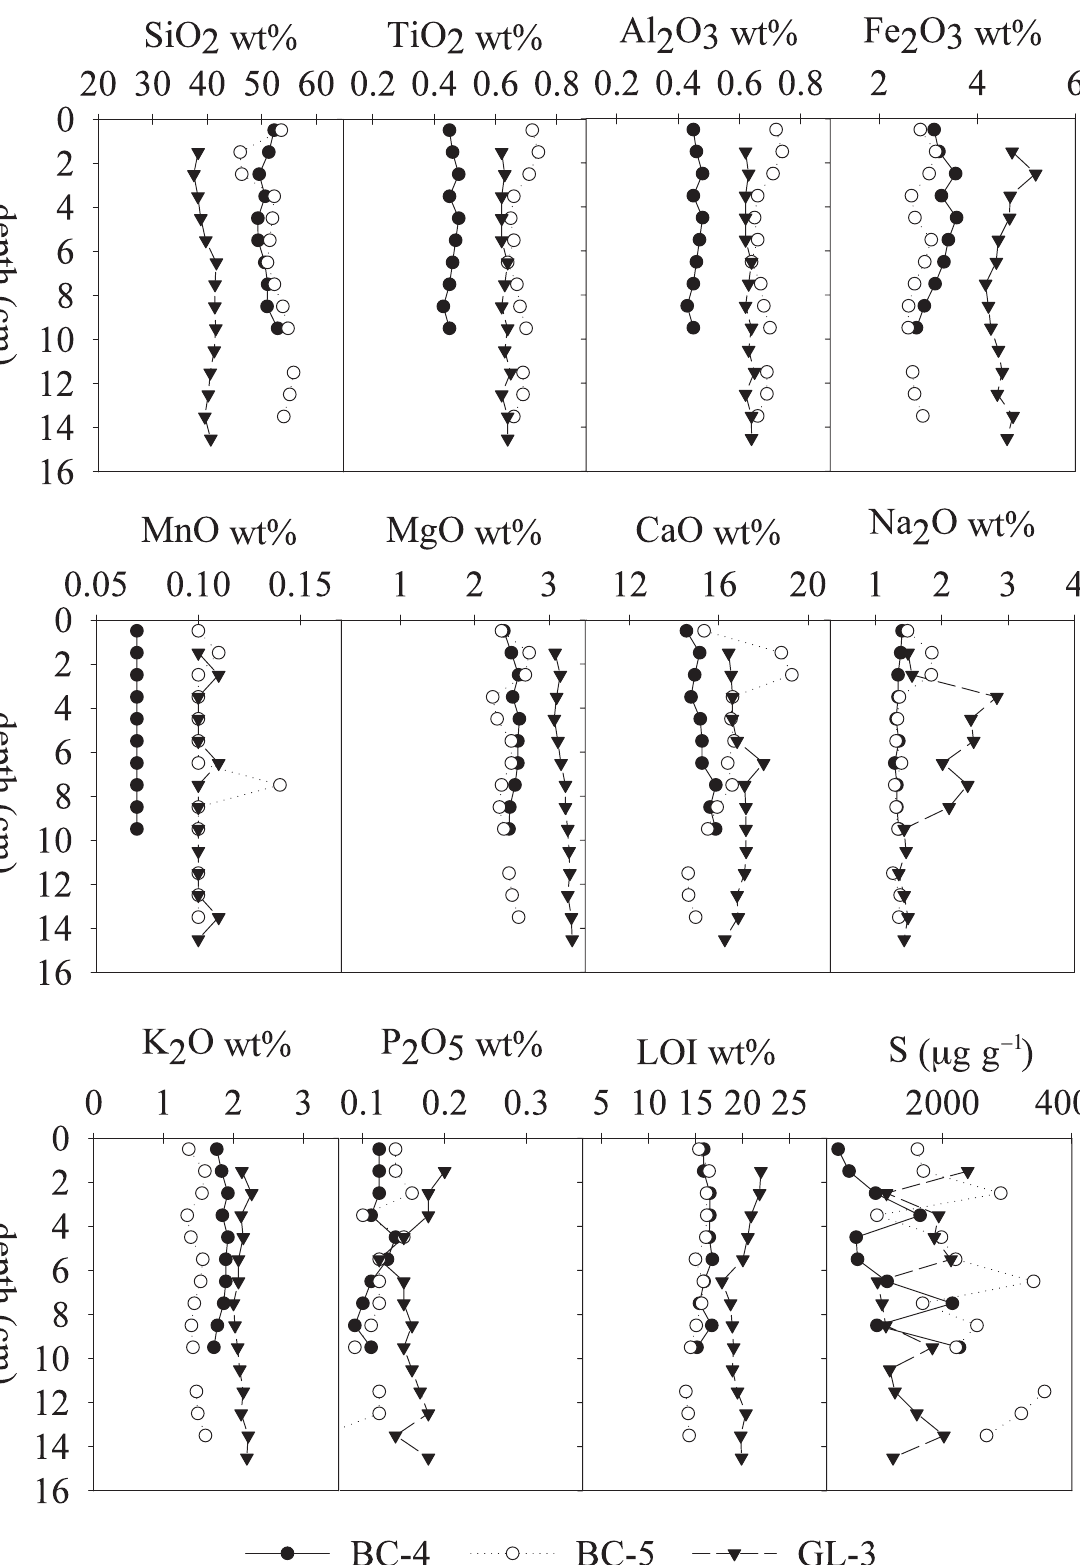
Fig . 3. – Depth profiles of major elements in the sediment cores from the Gulf of Cádiz. The origin of the cores is shown in Figure 1. Sediment cores BC4 and BC5 were obtained from the outer Bay of Cádiz, whereas core GL3 was obtained from the submarine prodelta of the